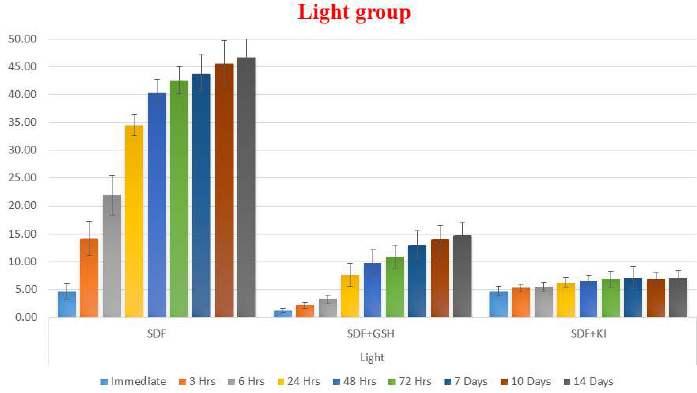
Figure 1. Bar chart showing mean ΔE for different tested groups for enamel substrate within each time interval under light exposed conditions. Table 2. Mean and SD for ΔE for different tested groups at all time intervals within enamel under dark conditions.